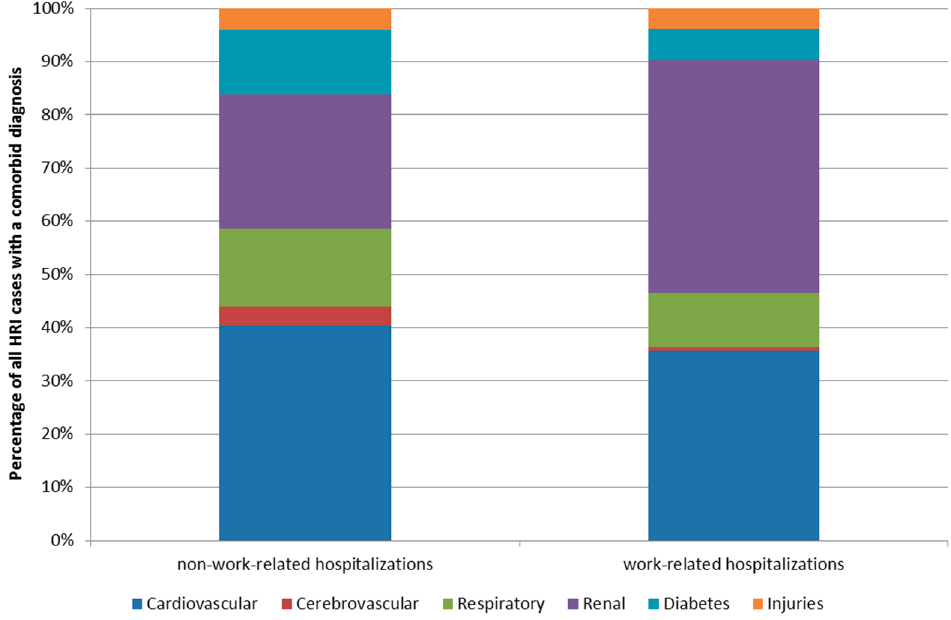
Figure 6. Distribution of co-morbid outcomes among Florida residents identified with HRI in the hospital, stratified by work-related status (2005–2012).